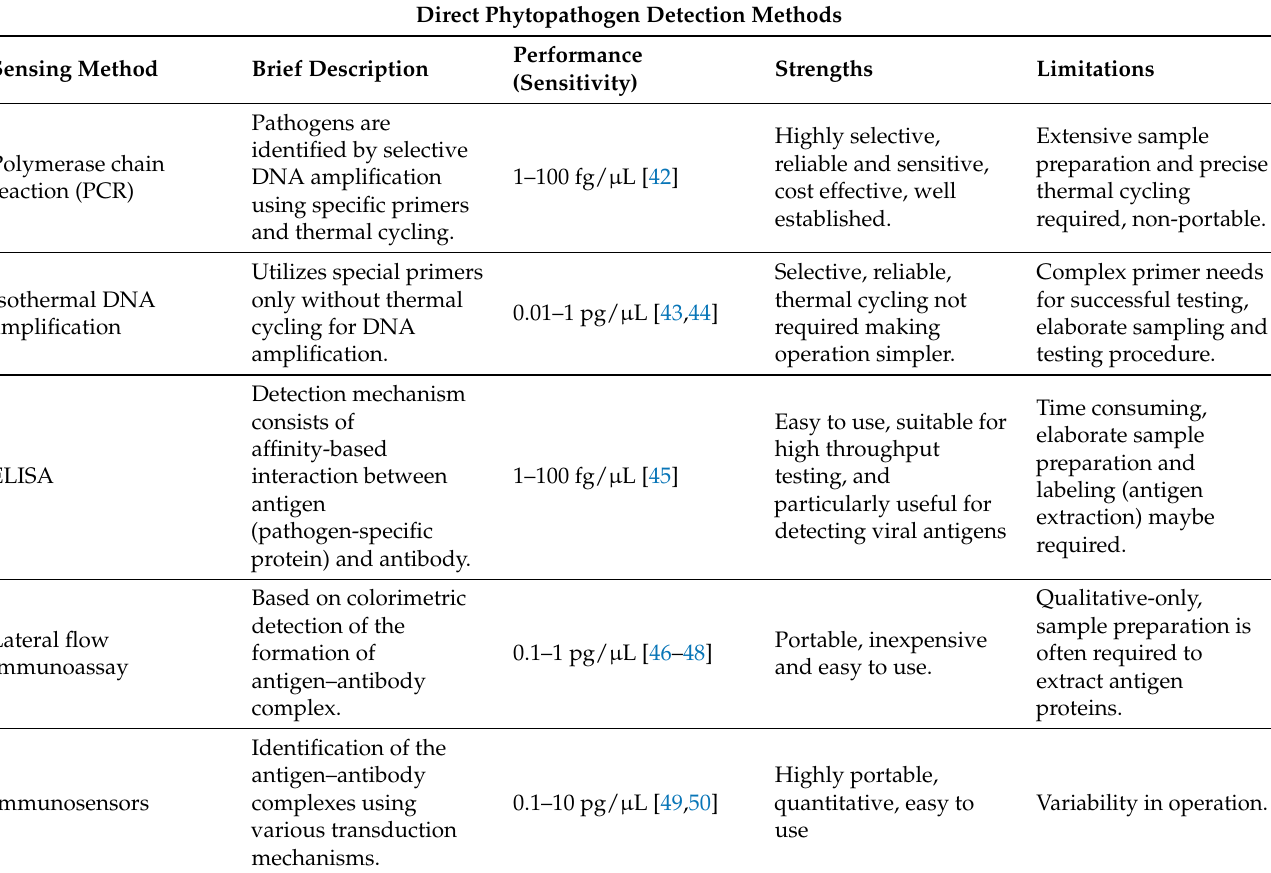
Table 1. Brief comparison of the direct sensing methods discussed in this article for monitoring phytopathogenic stress in